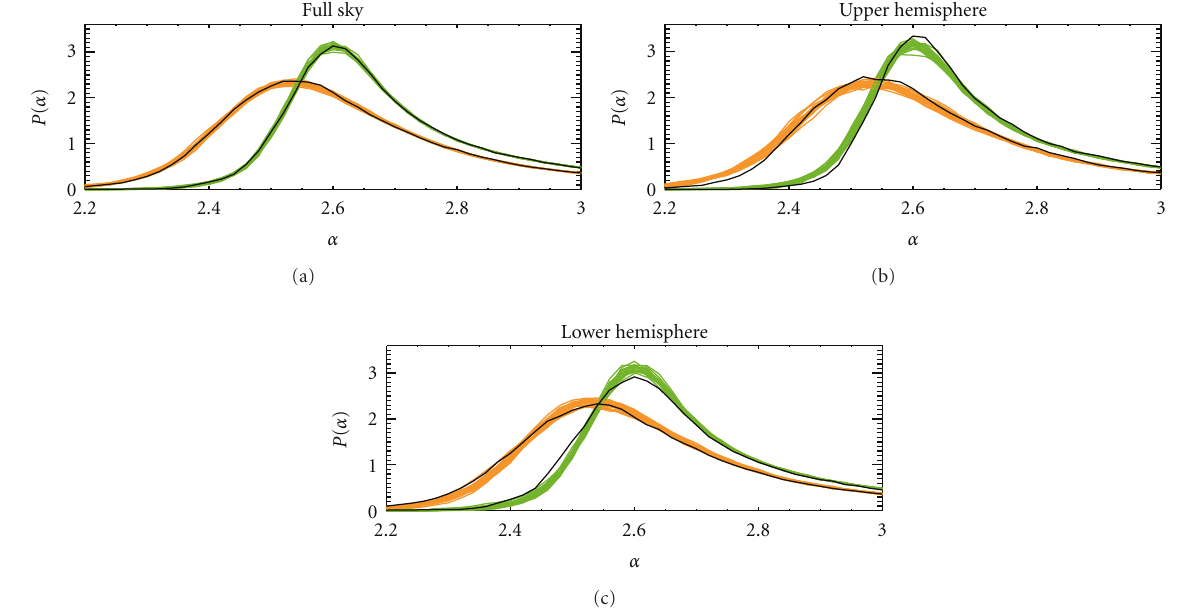
Figure 13: The probability densities P ( α ) of the scaling indices for the first-(black) and second-order surrogates (coloured) of WMAP 7-year data, calculated for the largest scaling range r 10 and for the (cid:9) -interval Δ (cid:9) = [2,20]. Yellow (green) curves denote the densities for 20 realizations of second-order surrogates derived from the ILC7 (NILC5) map. The reference frame for defining the upper and lower hemispheres is chosen such that the di ff erence Δ S = S up − S low becomes maximal for (cid:2) α (cid:3) of the respective map and respective scale r